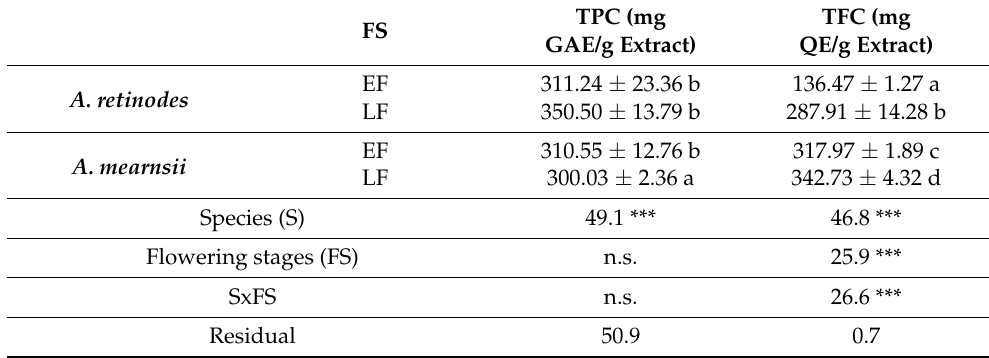
Table 1. Total phenolic compounds and flavonoids content (TPC and TFC) (mean ± standard deviation) of A. retinodes and A. mearnsii flowers extracts with different flowering stages.